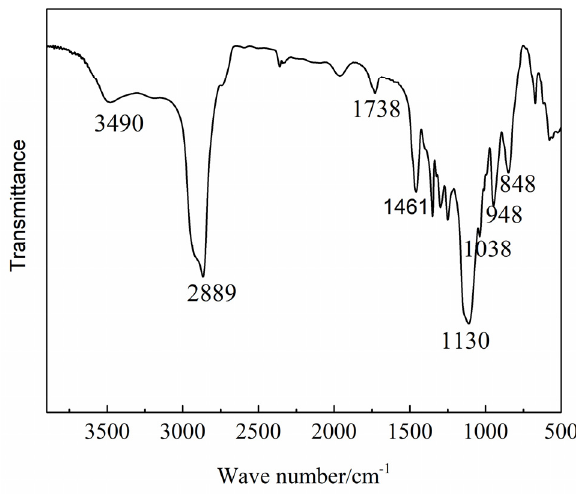
Figure 3. Infrared spectrum of the polysulfonate dispersant.